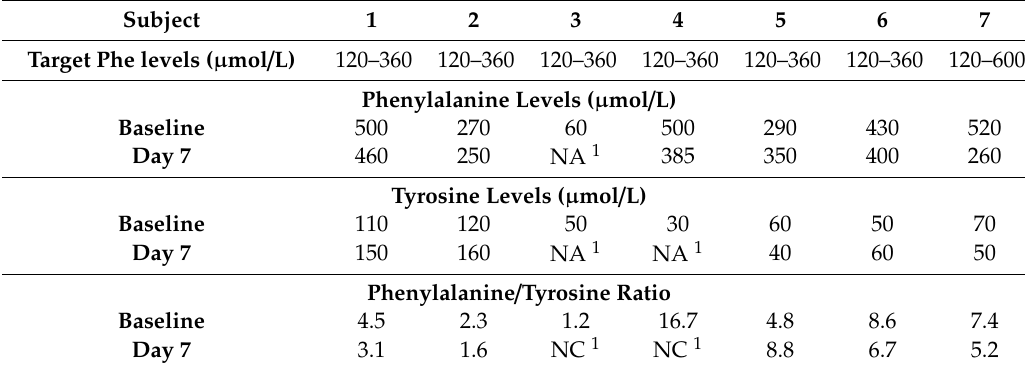
Table 3. Phenylalanine and tyrosine blood levels of the substudy patient cohort during the study.